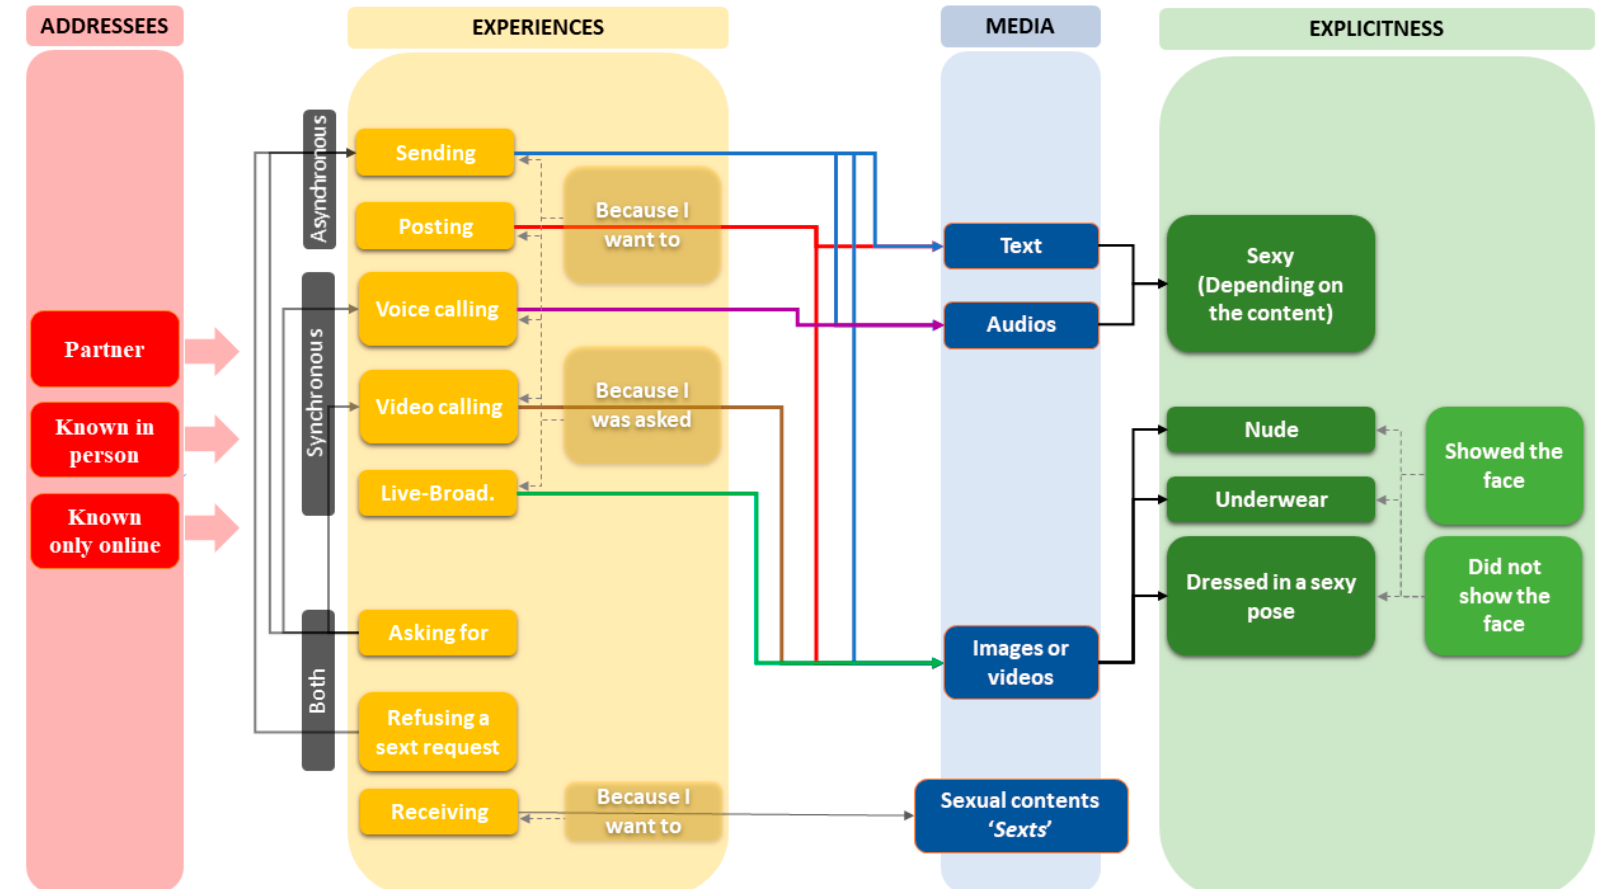
Figure 1. Graphical representation of the modular structure of A-SextS.